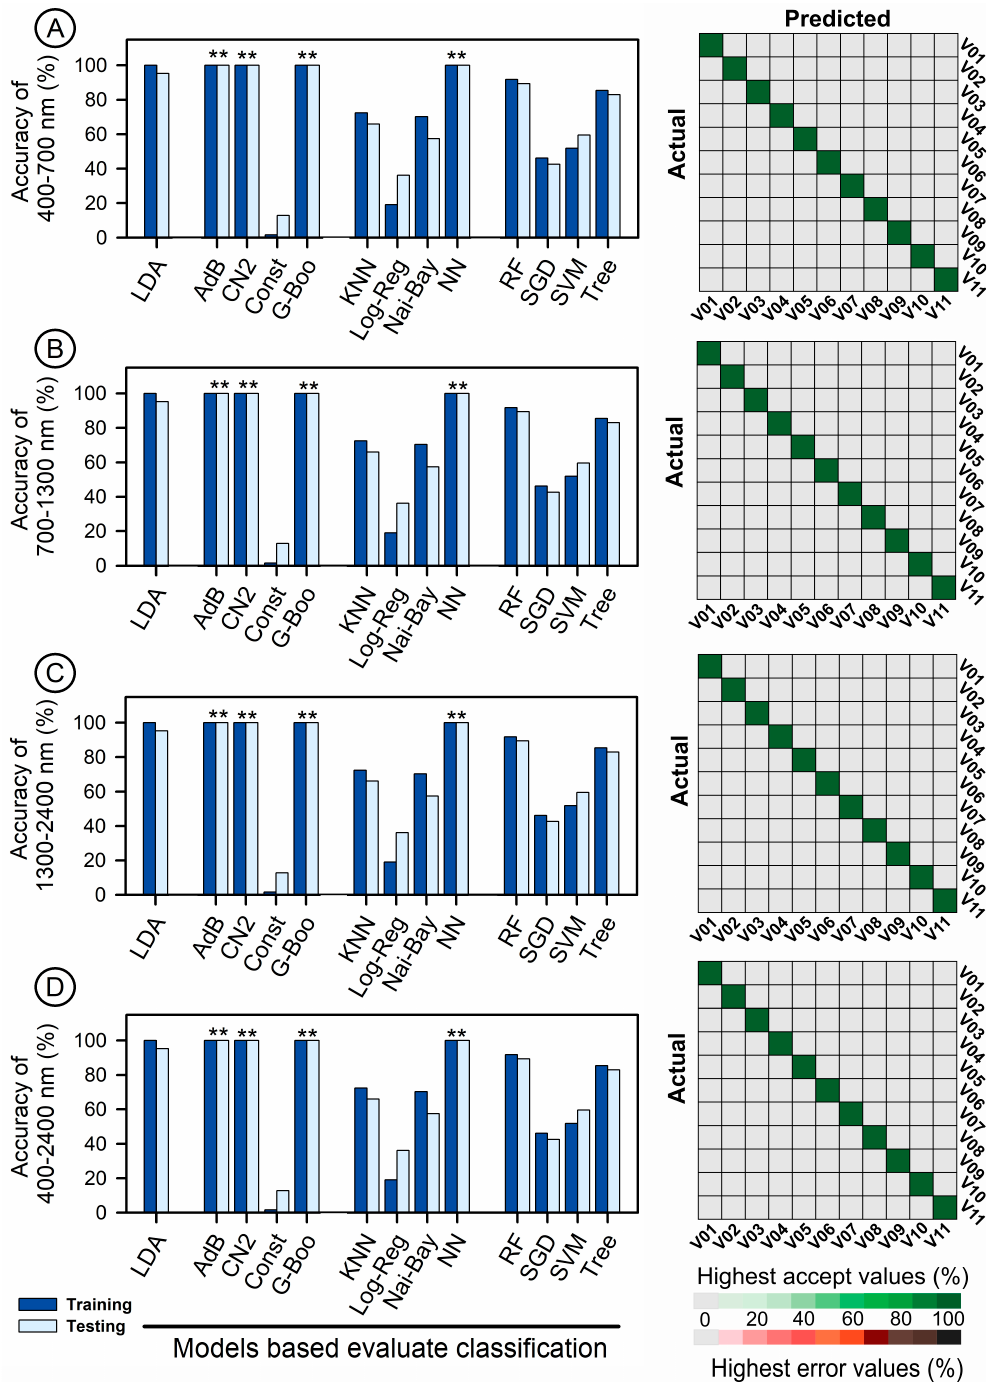
Figure 7. Evaluation of accuracy in training and testing for 17 algorithms including LDA, AdB, CN2, Const, G-Boo, KNN, Log-Reg, Nai-Bay, NN, RF, SGD, SVM, and Tree using VIS-NIR-SWIR hyperspectral data for lettuce phenotypic characterization. ( A ) Spectral range of 400–700 nm. ( B ) Spectral range of 700–1300 nm. ( C ) Spectral range of 1300–2400 nm. ( D ) Spectral range of 400–2400 nm. ** asterisk shows accuracy below 99.9% and accepts values for classification based on those algorithms ( n = 66).